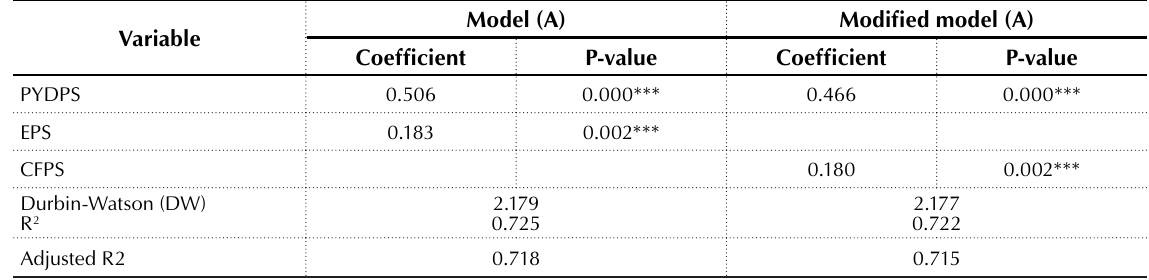
Table 10. Results of Lintner’s model (model (A) and (modified model